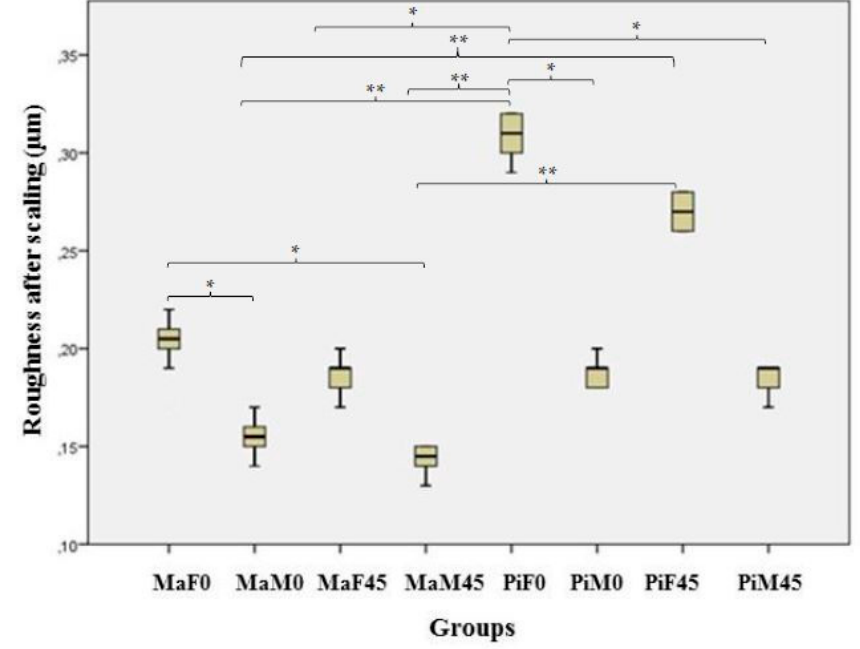
Figure 6. Roughness values in different scaler groups. *Mann–Whitney U posthoc Bon Ferroni Correction, p < 0.01; **Mann–Whitney U posthoc Bon Ferroni Correction, p <